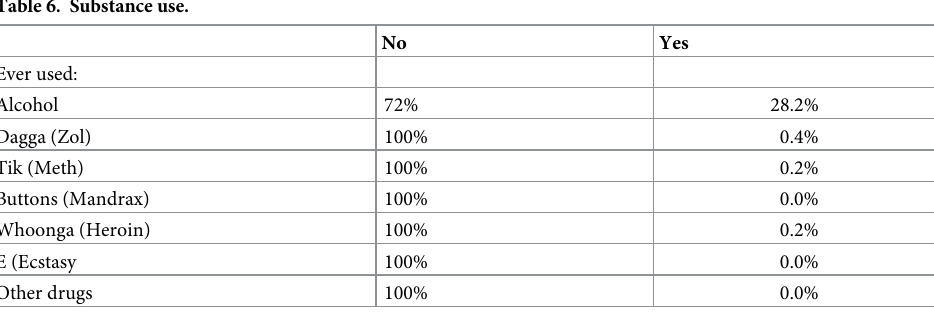
Table 6. Substance use.